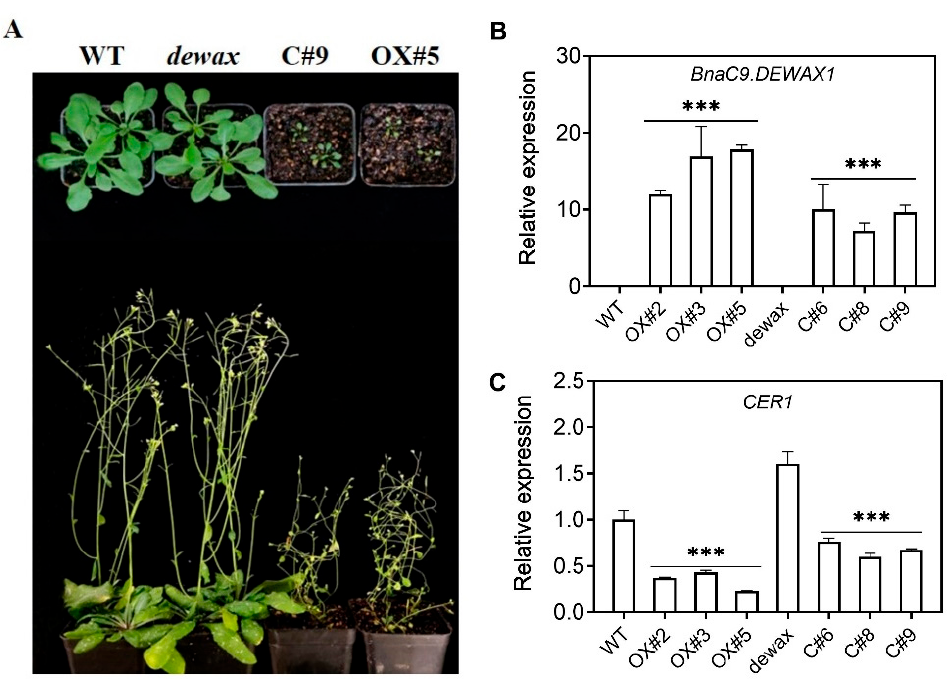
Figure 4. The transcription level of BnaC9.DEWAX1 and CER1 in Arabidopsis and phenotypic characterization of BnaC9.DEWAX1 transgenic plants. ( A ) Phenotype of Arabidopsis wild type and BnaC9.DEWAX1 overexpression and complementation lines. ( B ) Increased transcription level of BnaC9.DEWAX1 in overexpressing and complementation lines relative to wild type. ( C ) Down-regulation of CER1 involved in cuticular wax biosynthesis by BnaC9.DEWAX1. Total RNA was extracted from the leaves of four-week-old Arabidopsis. Error bars indicate ± SD from three biological replicates. Data were statistically analyzed using Student’s t -test (*** p < 0.001). Overexpression of BnaC9.DEWAX1 in A. thaliana WT significantly reduced the con- tents of alkanes, secondary alcohols, ketones, primary alcohols, and total wax on stems (Figure 5A), and the contents of fatty acids, alkanes, and total wax on leaves (Figure 5C). For wax components, BnaC9.DEWAX1 gene overexpression mainly decreased the contents of C 29 alkanes, C 29 secondary alcohol, and C 29 ketones, the three predominant compounds in total wax, as well as C 28 aldehyde and C 28 primary alcohols on the stem (Figure 5B). For leaf, BnaC9.DEWAX1 gene overexpression mainly decreased the contents of C 26 fatty acid and C 29 , C 31 , and C 33 alkanes (Figure 5D). As described previously [19], the dewax mutant plants showed higher contents of wax compositions and total wax on both stem and leaves compared with the WT. When the BnaC9.DEWAX1 gene driven by the CaMV 35S promoter was expressed in Arabidopsis dewax plants, no significant differences in wax depositions on stems and leaves were observed between the complementation lines and the WT (Figure